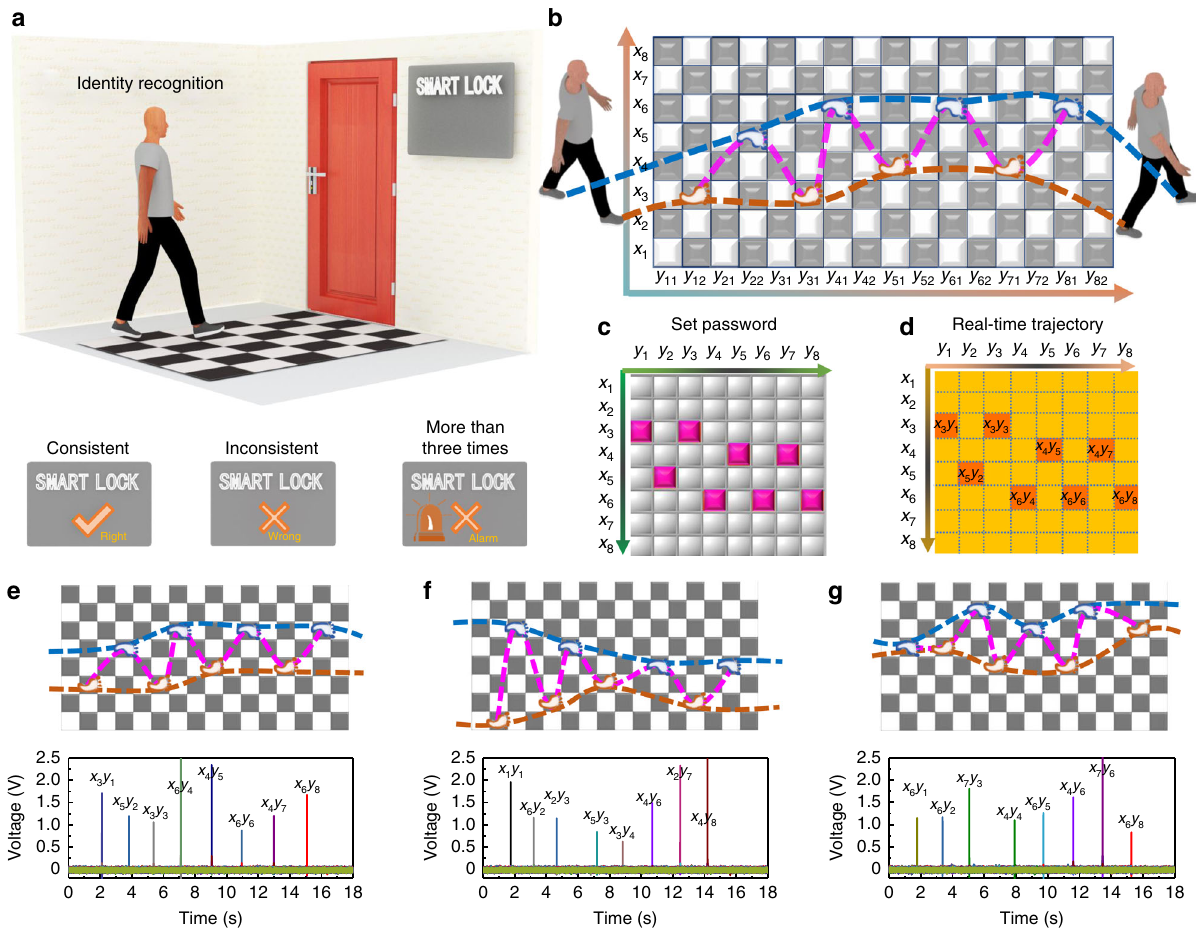
Fig. 6 A self-powered identity recognition carpet for safeguarding entrance and early warning of intrusion. a Schematic illustration of the self-powered identity recognition system. There will be three states displayed on the screen, i.e., “ √ ” , “ × ” , and “ × ” accompanied by an alarm indicator. b Schematic illustration of the human walking trajectories on the identity recognition carpet. The magenta, blue, and brown dotted lines represent the walking routes of the whole person, the left foot, and the right foot, respectively. Moreover, the small blue and brown foot symbols refer to the left foot and the right foot, respectively. c , d Schematic illustrations of ( c ) the set password path and ( d ) the real-time walking path. e – g Real-time walking trajectories on the identity recognition carpet, which correspond to the path with ( e ) the correct password, ( f ) the incorrect password for the fi rst time, and ( g ) the incorrect password for more than three consecutive times when evaluated against the set password path. The voltage signals of 64 sensing blocks are presented below the corresponding walking trajectories and the positions of the stepped sensing blocks are marked above each curve. Source data are provided as a Source data fi